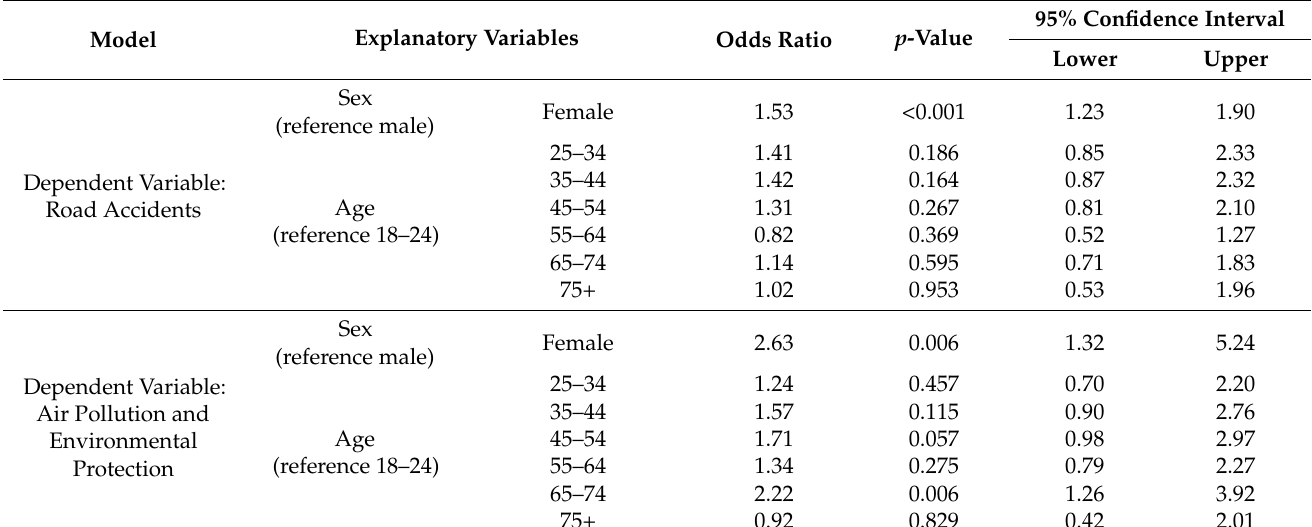
Table A1. Multivariate ordered logistic regression models for perceived importance of public health risks.